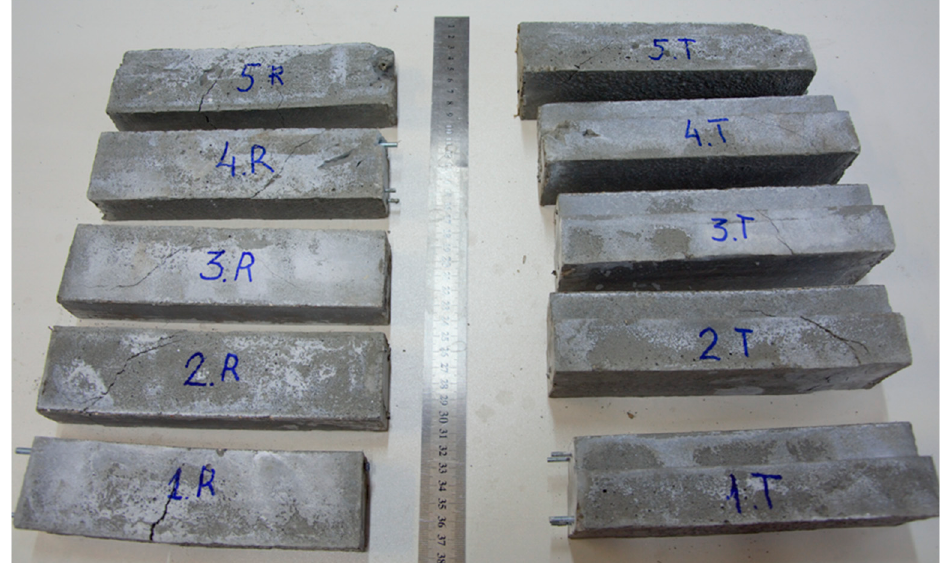
Figure 13. Test specimens after testing (on the element marked 1R, destruction is visible in the normal section due to an error during testing: a small reinforcement with a diameter of 2 mm was found in the tension zone.